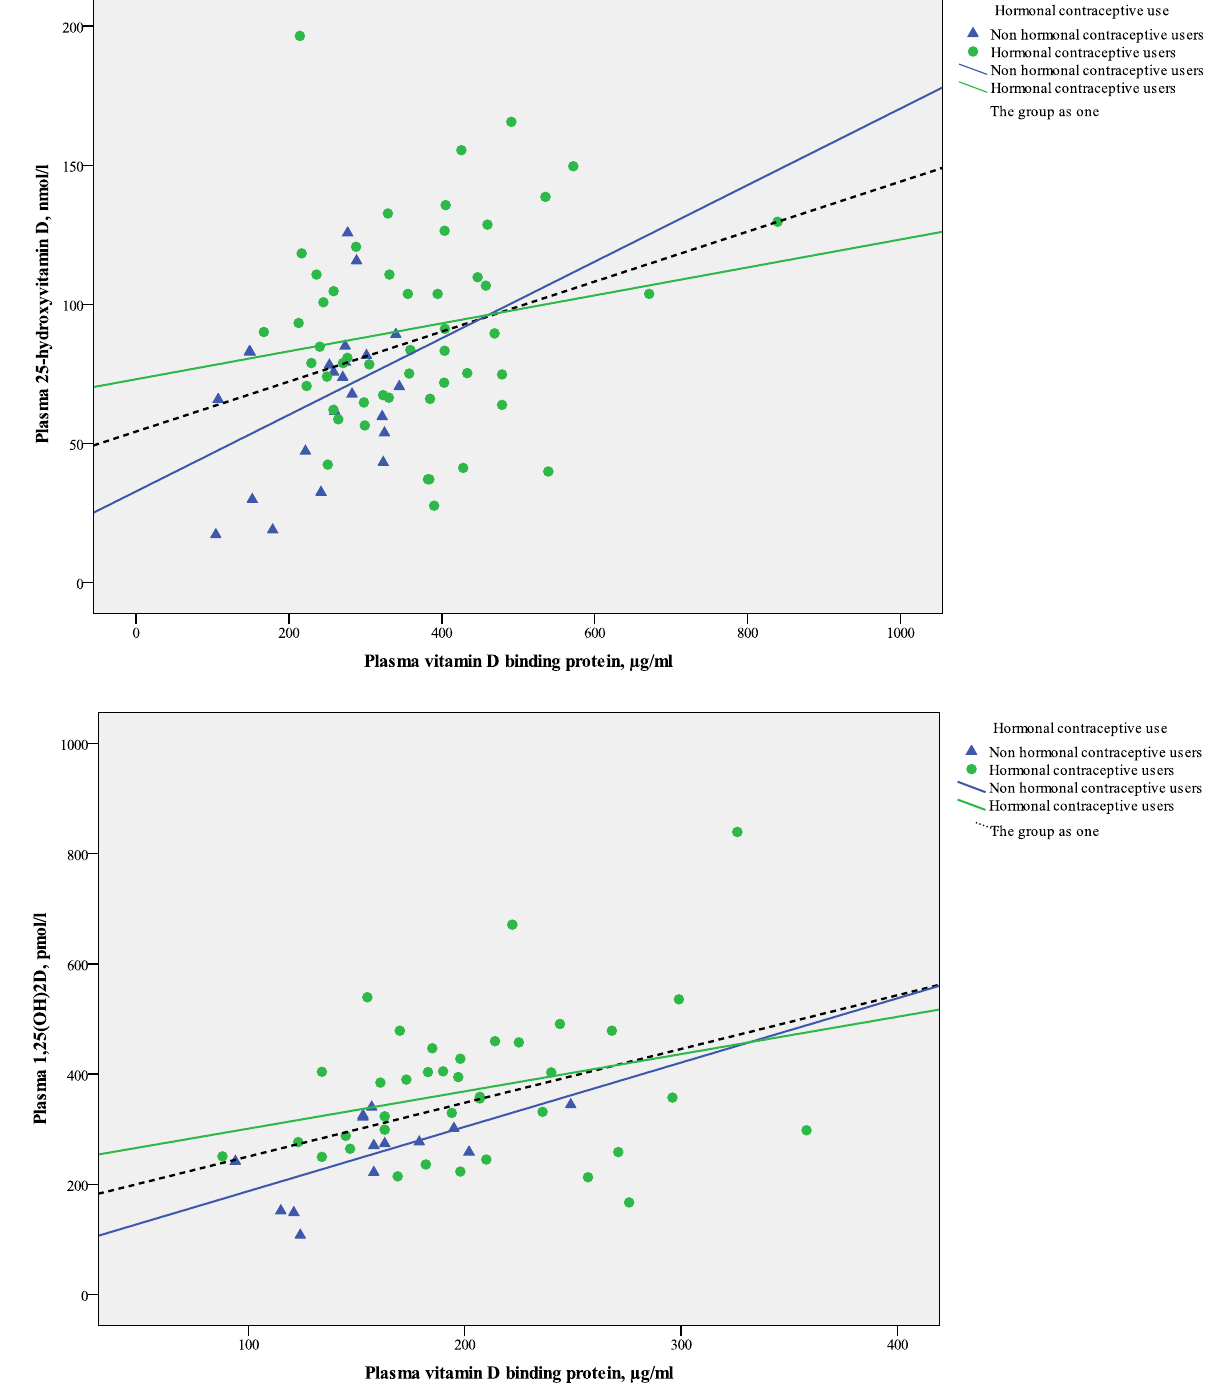
Figure 1. ( A ) Scatter plot of linear relations between plasma 25OHD and VDBP in 75 healthy Caucasian women stratified by use of hormonal contraceptives; ( B ) Scatter plot of linear relations between plasma 1,25OH D and VDBP in 75 healthy Caucasian women 2 stratified by use of hormonal